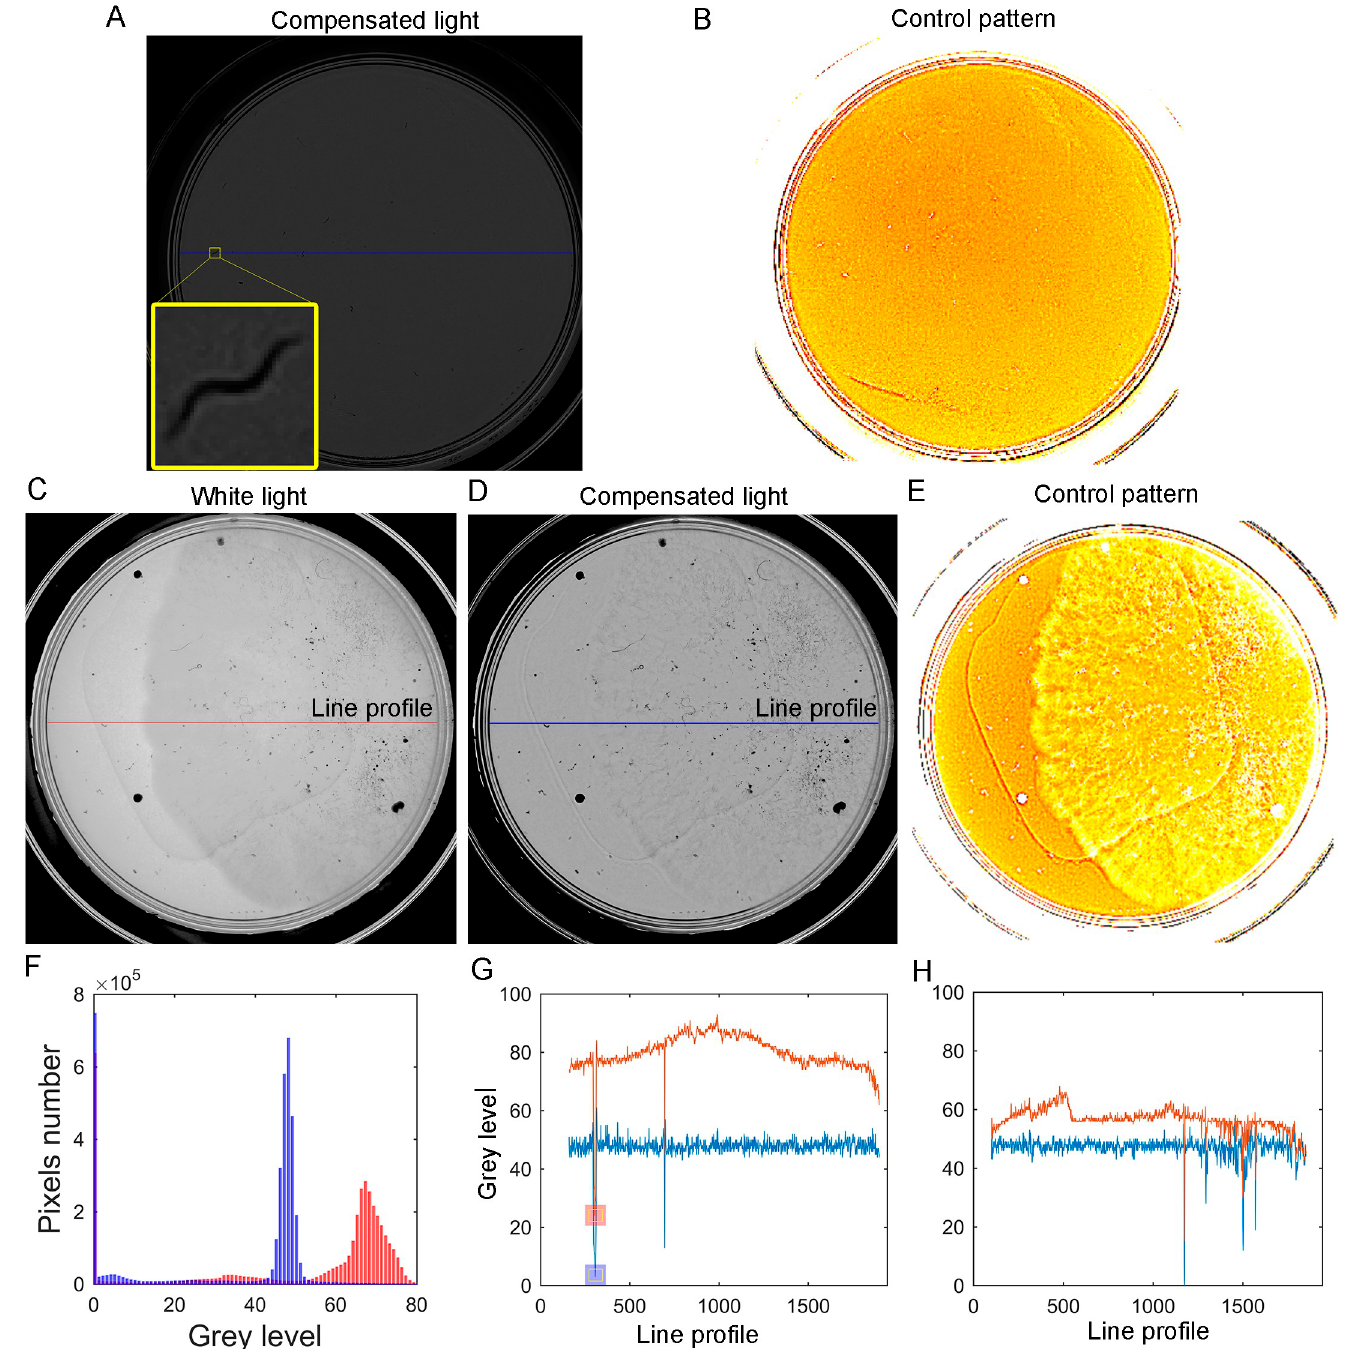
Fig 6. Spatial variability under white light. A: Captured image with compensated illumination. B: Control pattern applied to the captured image. C: Normalised image with white backlight. D: Normalised image with compensated light. E: Control pattern applied to the captured image (C). F: Comparison of the image histograms: the red one without applying any control and the blue one after applying the control. G: Comparison of profile lines, the red one without applying the control to (A) and the blue one after applying the control (A). The blue and red squares are the grey levels caused by a worm. H: Comparison of profile lines (C) and